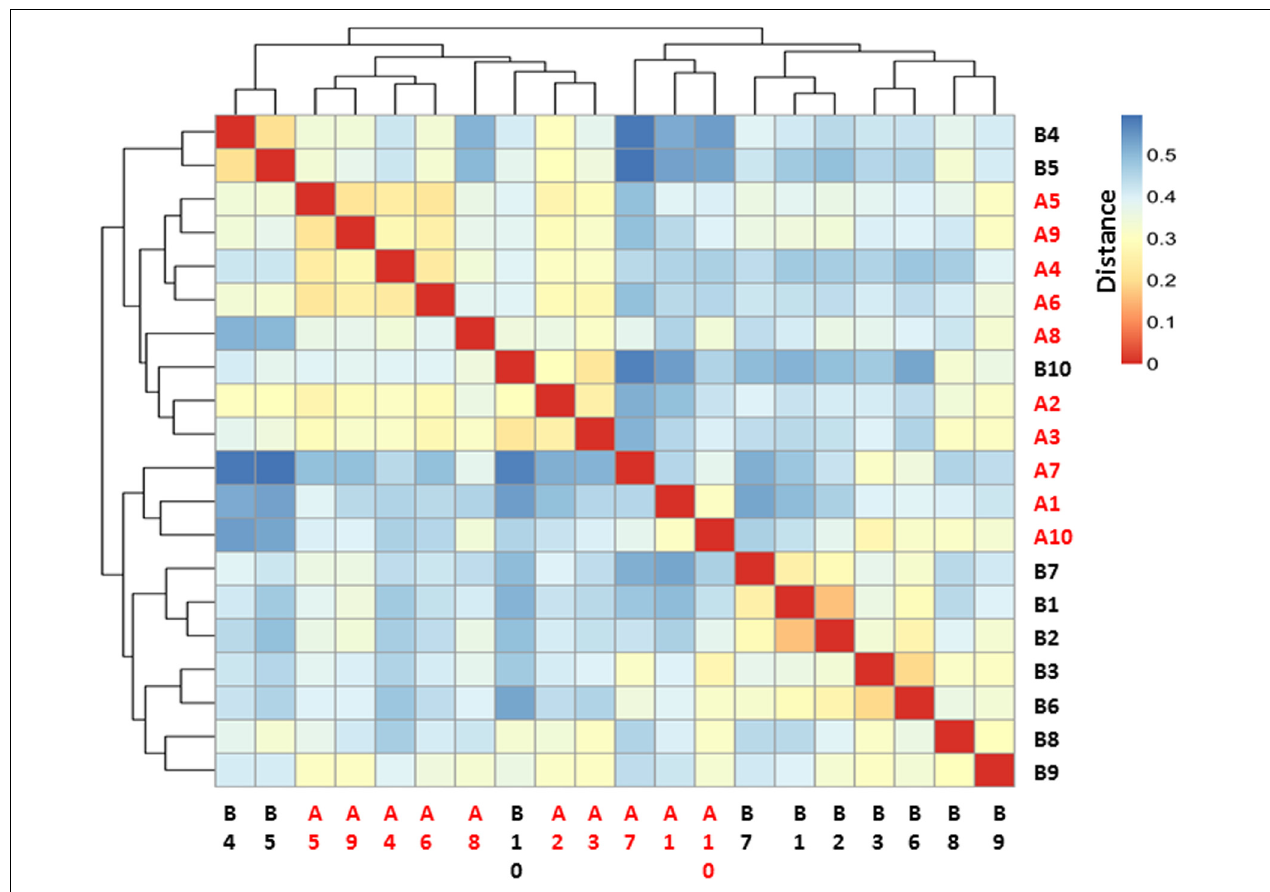
FIGURE 3 | Heatmap for sample–sample distance. Red color indicates the nearest distance and blue color indicates long sample–sample distance. Pre-burn samples were named as B1–B10 in black and post-burn samples were named as A1–A10 in red.